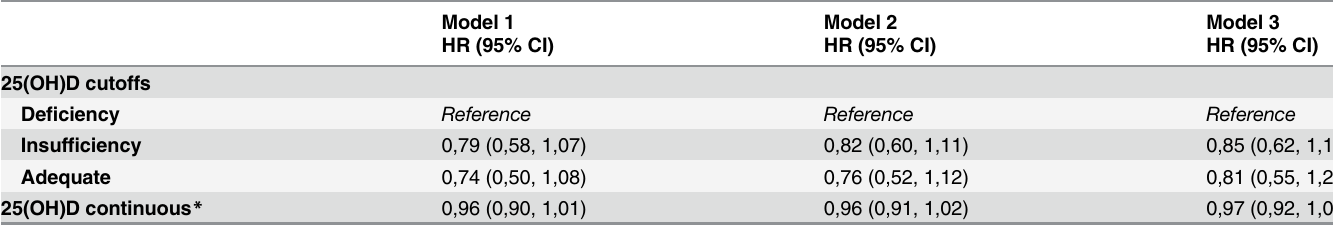
Table 2. Serum 25(OH)D and incidence of atrial